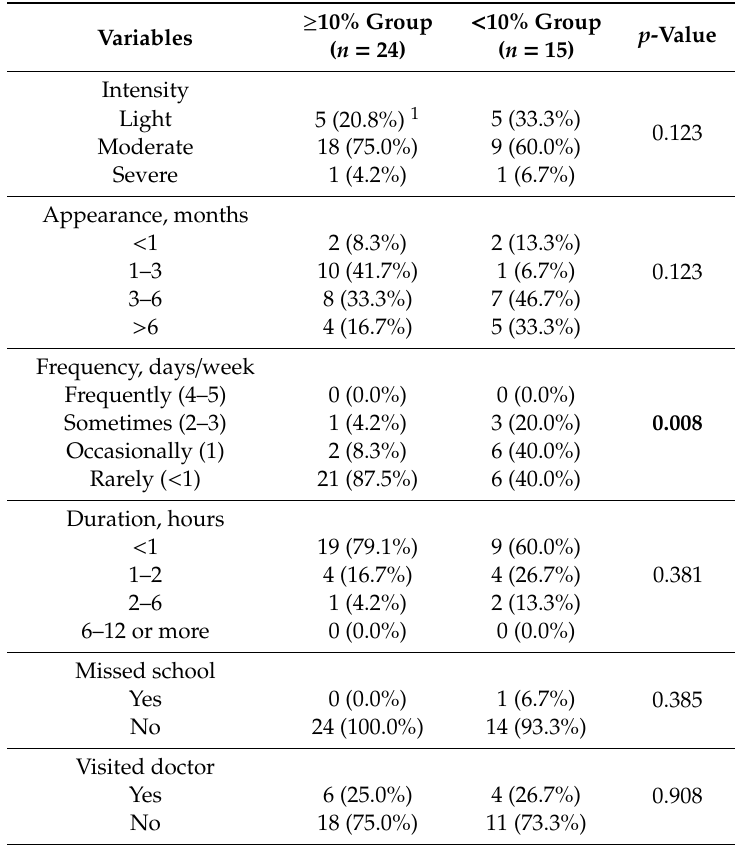
Table 2. Characteristics of pain.